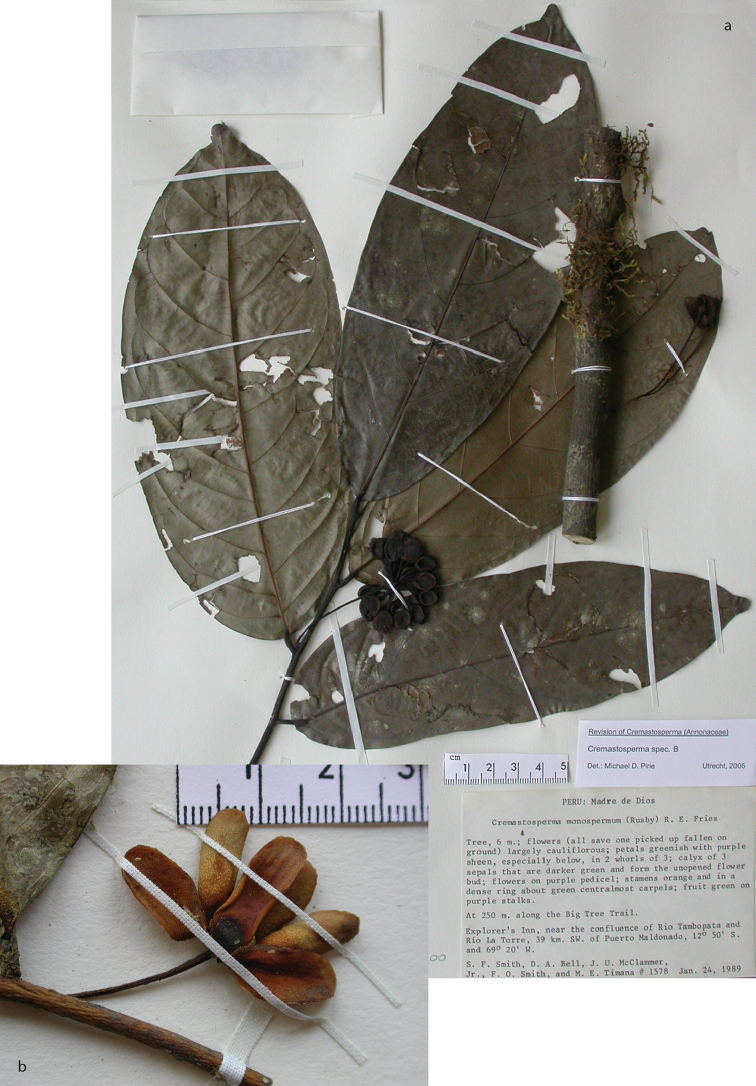
Cremastospermaconfusum Pirie. a fruiting and flowering specimen b flower (aSmith, S. et al. 1578bSmith, S. et al. 794).